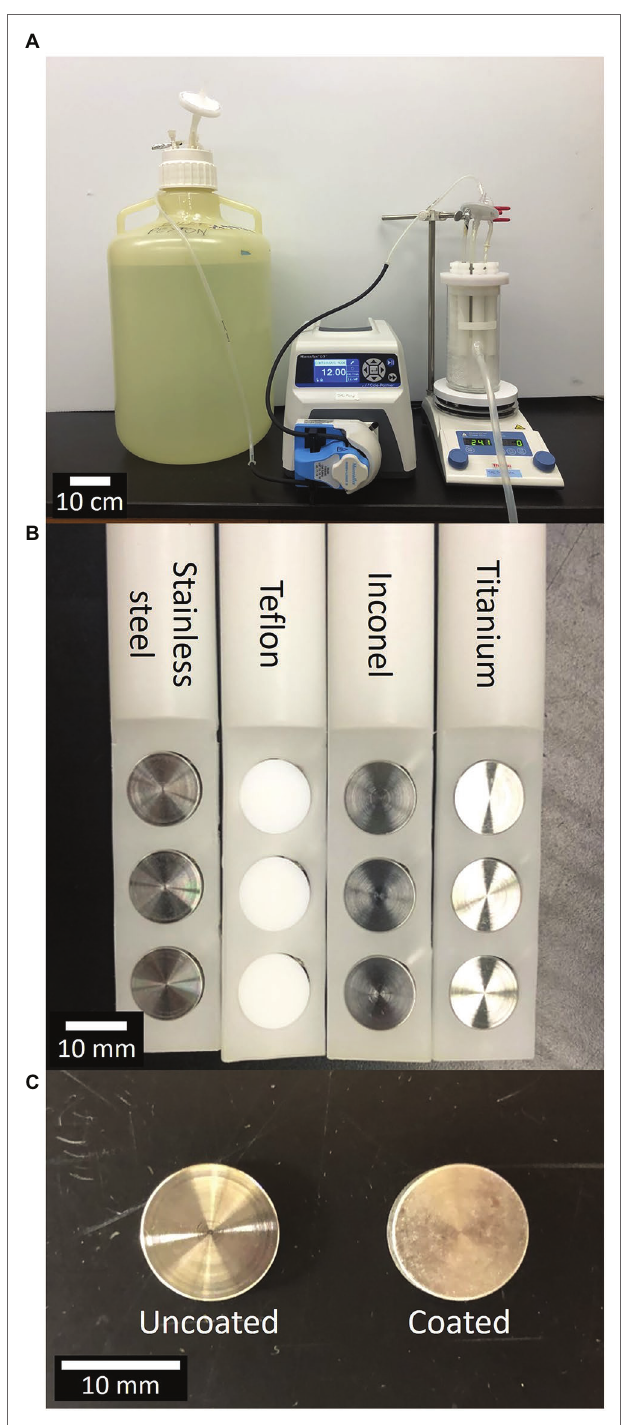
FIGURE 1 | Center for Disease Control (CDC) bioreactor, material types, uncoated vs. coated materials. (A) Experimental setup consisting of 20 L carboy, peristaltic pump, and CDC Biofilm Reactor atop a stir plate. (B) Close-up of materials loaded into CDC Biofilm Reactor rods, from left to right, materials are stainless steel, Teflon, Inconel, and titanium. (C) Close-up of two titanium materials without coating (left) and with antimicrobial coating